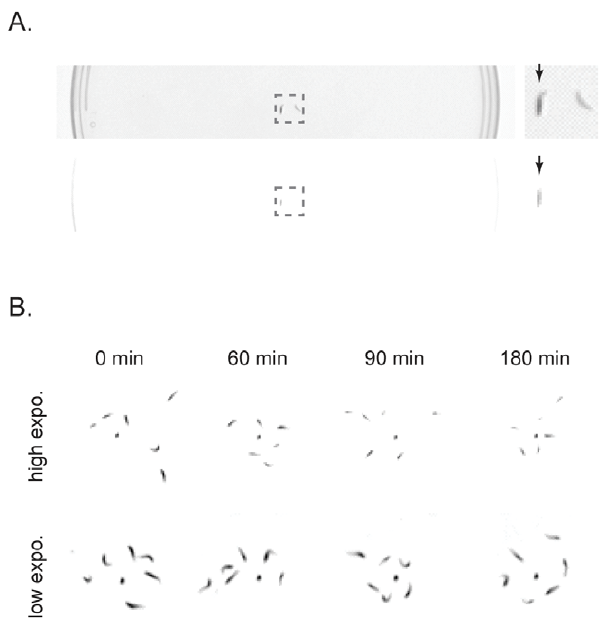
Figure 1. Feeding larvae black dyed food enhanced contrast. A. Dyed and control larvae in 15 cm plastic petri-dish under recording camera. Top: Dyed and control larvae under low exposure. Bottom: Same larvae under high exposure, where the petri-dish edge is barely visible. Arrows indicate dyed larva. B. Dye fed larvae were visible under high exposure for up to 3 hours after extraction.